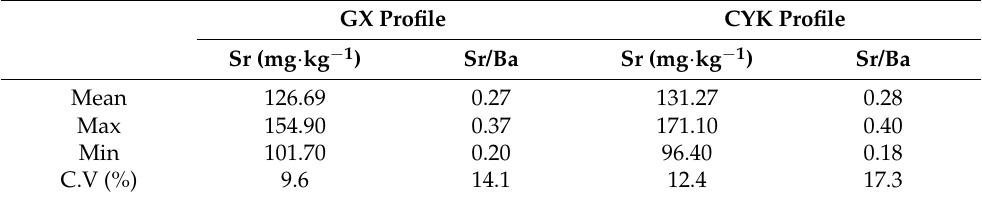
Table 2. Changes of Sr and Sr/Ba of sediment of GX and CYK profiles.